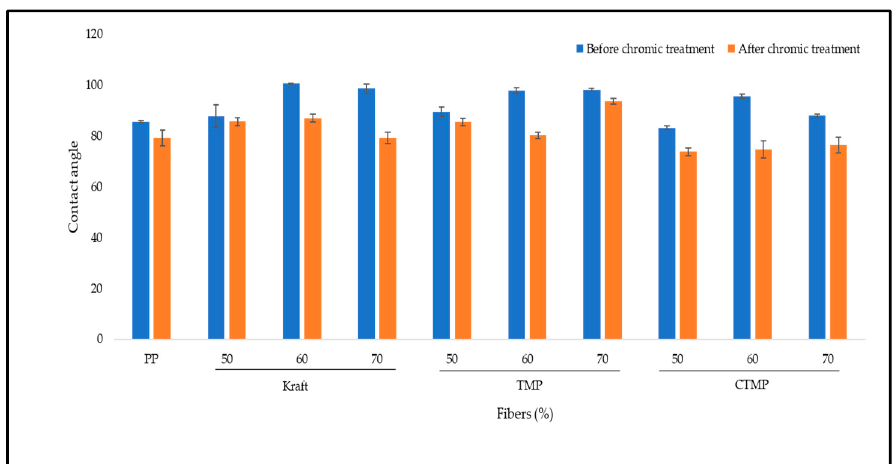
Figure 5. Contact angle evolution before and after chromic treatment.